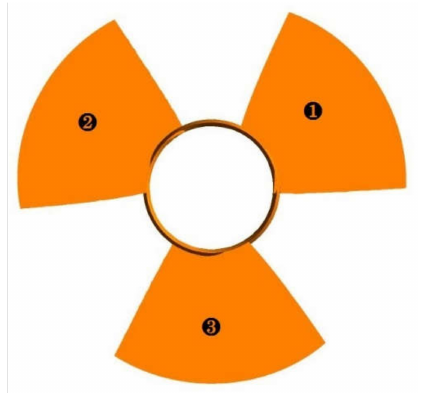
Figure 2. The impeller of an axial flow